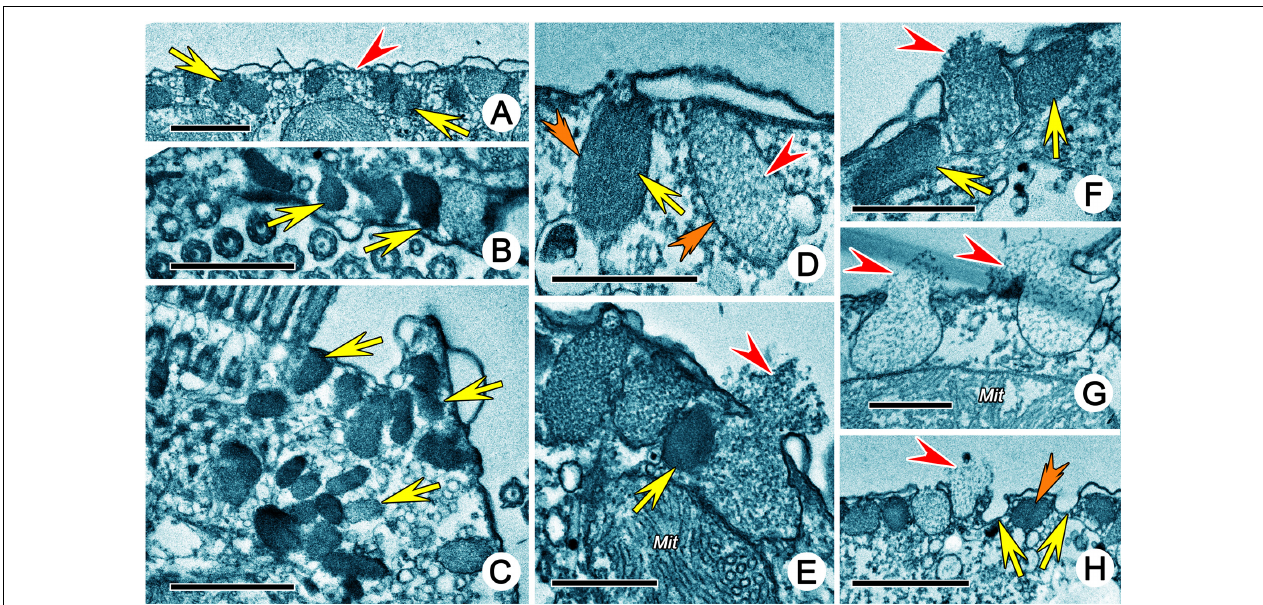
FIGURE 4 | Extrusomes of Uronychia binucleata in the transmission electron micrographs. (A) Extrusomes (arrows) under pellicle. Arrowhead marks microtubule. (B,C) Sections near the buccal region (B) and cirri (C) , showing the arrangement of extrusomes (arrows) in buccal region (B) and around cirri (C) . (D) Extrusomes with different electron density, arrow points to the electron-dense extrusome, while arrowhead points to the electron-lucent extrusome. Double-arrowheads indicate the unit membrane around extrusomes. (E–G) Longitudinal section of extrusomes, showing the fusion of extrusome membrane with pellicle and extruding of diffuse content (arrowheads). Arrows point to extrusomes which are not extruding. (H) Section perpendicular to pellicle showing extrusomes with different stages of extrusion: resting (double-arrowhead), extruding (arrowhead) and extruded (arrows show the membrane of extrusome which remains in place after extrusion). Mit, mitochondria. Scale bars = 1 µ m (A–C,H) , 0.5 µ m (D–G)